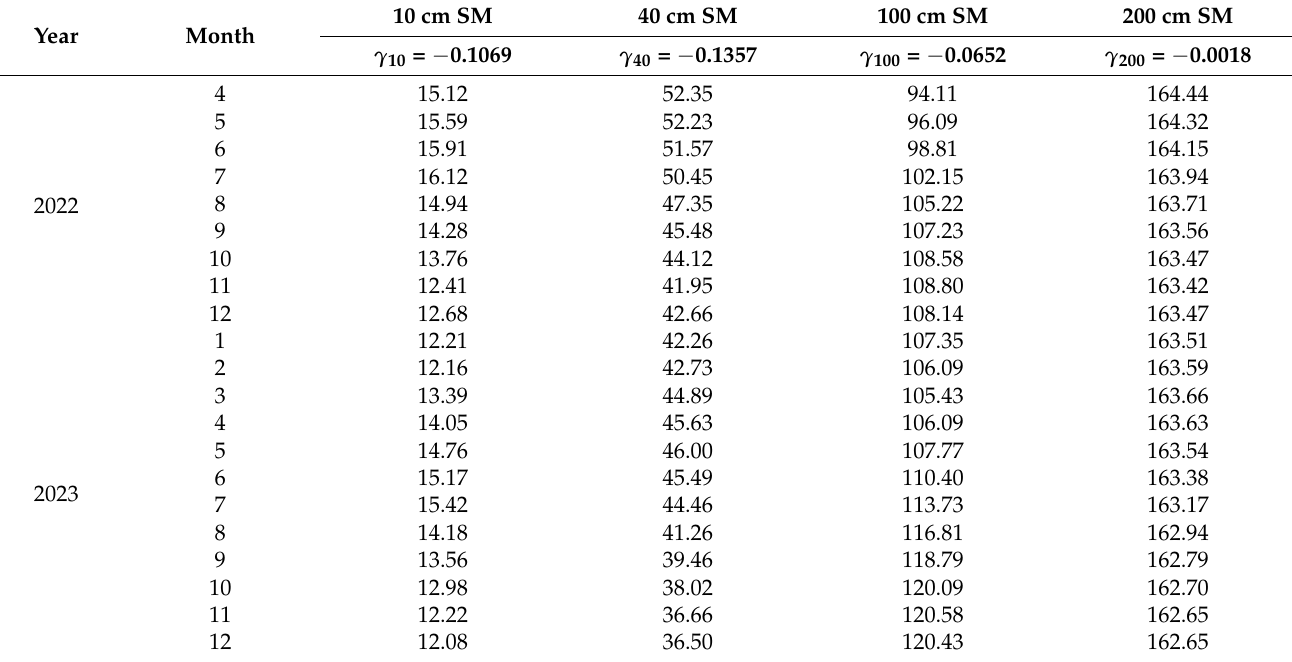
Table 6. Predicted values of the soil moisture, based on the depth and water balance